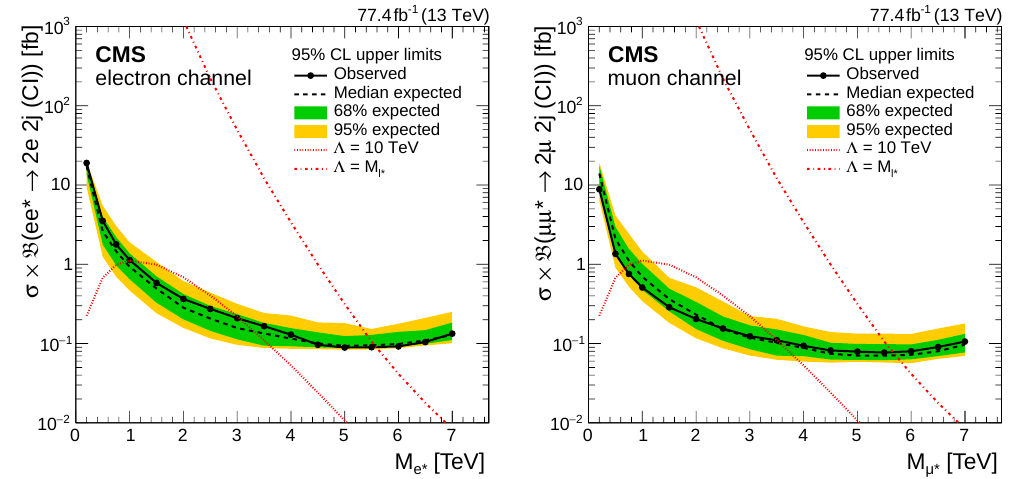
Figure 8 . Limits at 95% CL on the product of the production cross section and branching fraction for ‘‘ (cid:3) ‘‘jj , as a function of the excited lepton mass M ! (right) channels. The expectation from the model is represented for